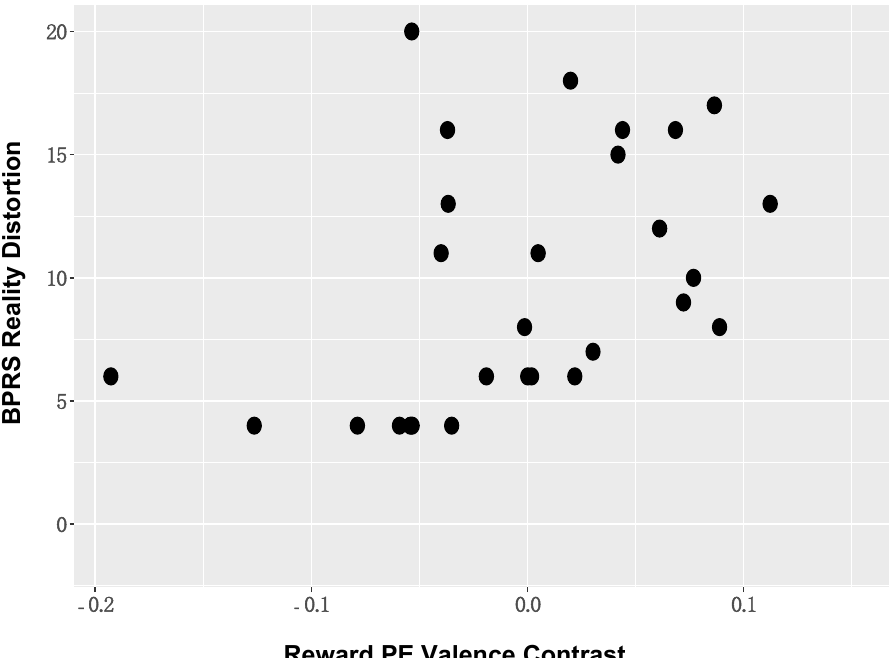
Figure 6. Positive Symptom Severity and DMN BOLD Activation: Positive symptom severity (BPRS reality distortion) in those with schizophrenia was positively associated with BOLD activation in DMN nodes, including the left supramarginal gyrus.